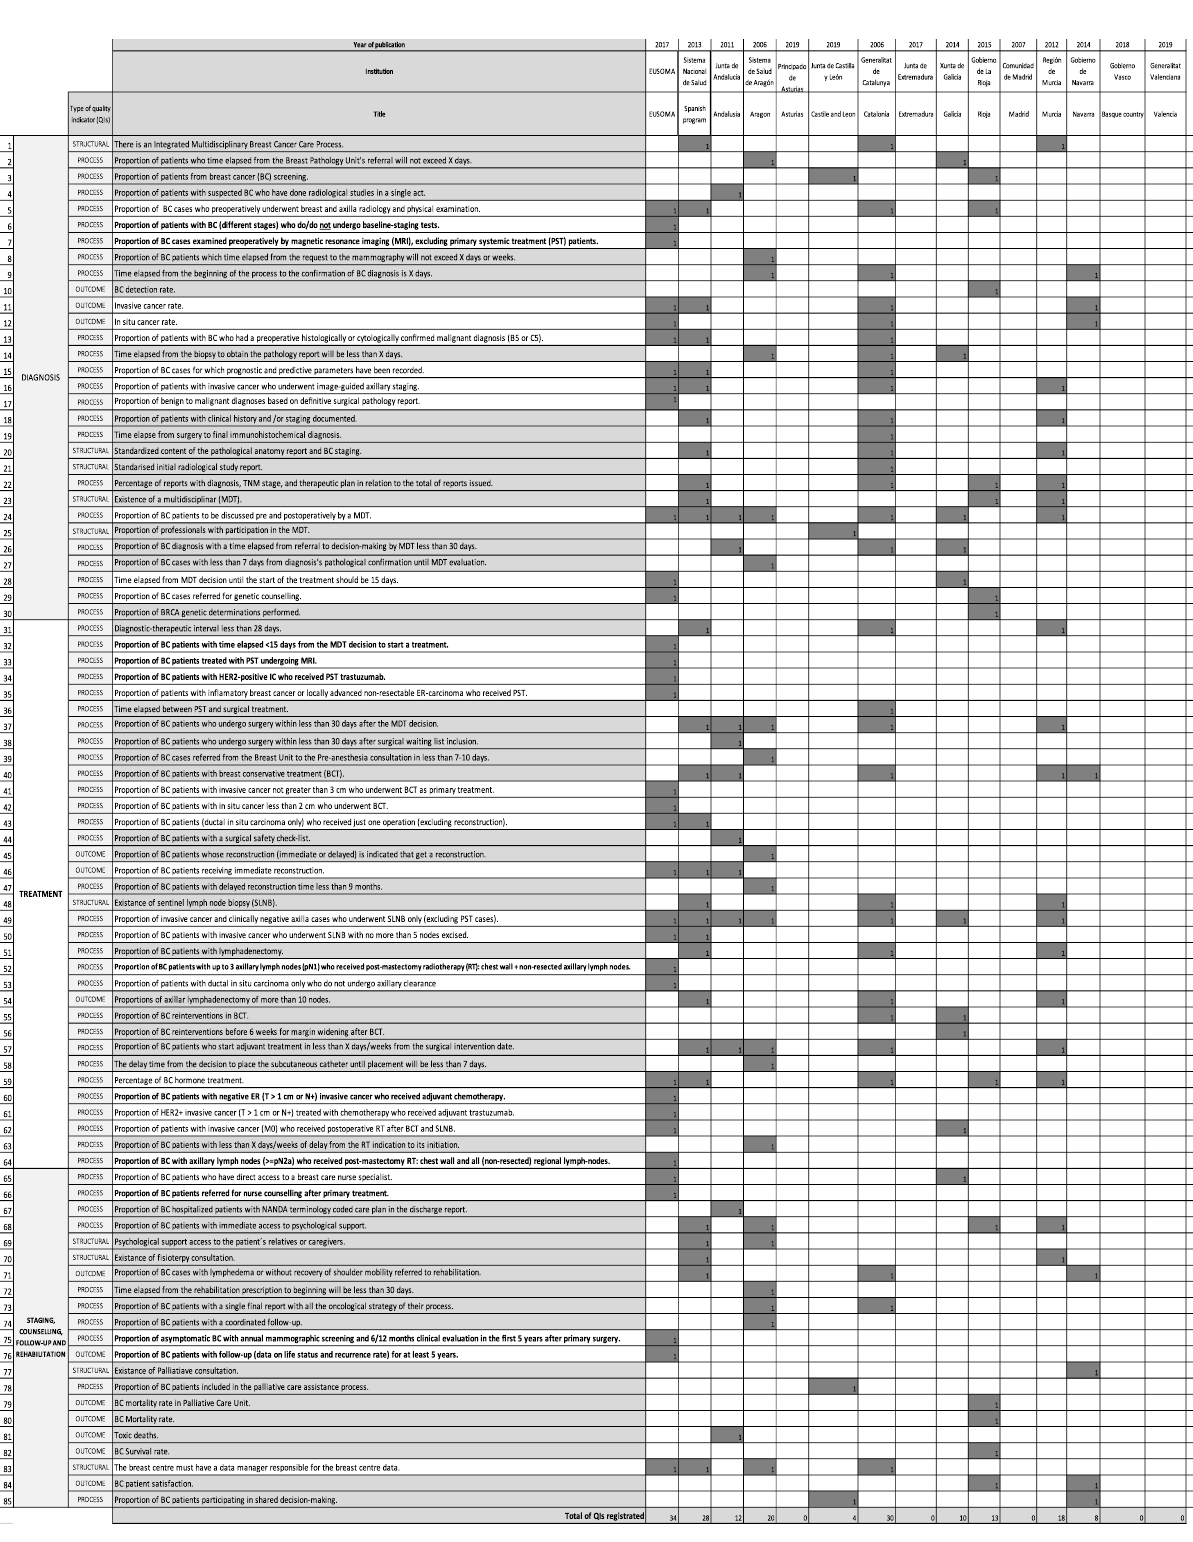
Figure 2. Appearance of the quality indicators (QIs) on diagnosis, staging, counselling, follow-up, and rehabilitation and others in the integrated BC health care process and clinical pathways analysed. QIs in bold were just published in EUSOMA. QIs in grey appeared in the Spanish documents analysed but not in the EUSOMA position paper.